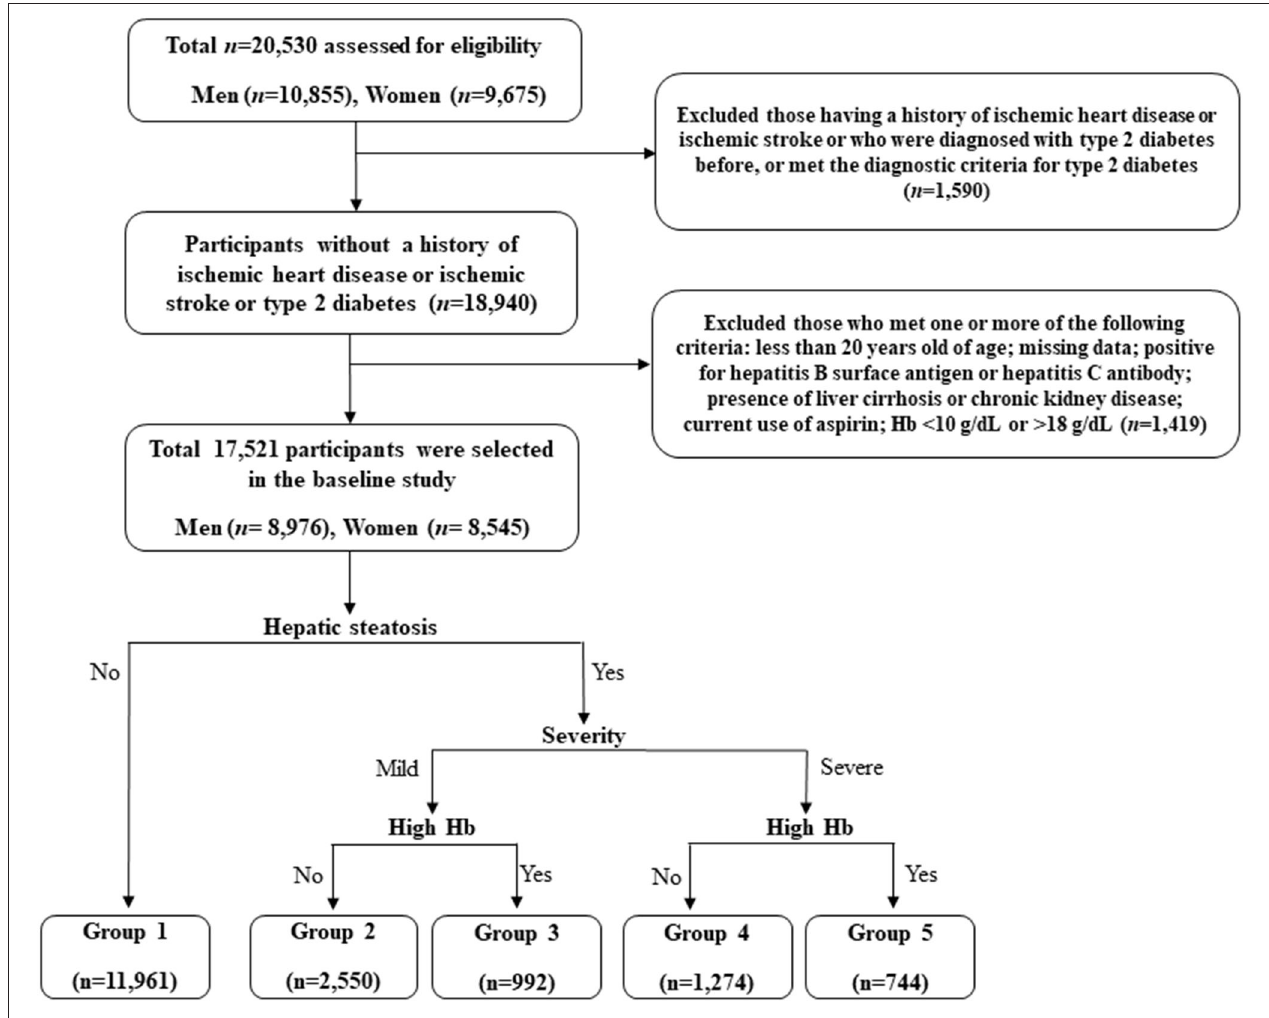
FIGURE 1 | Flowchart for the selection of study